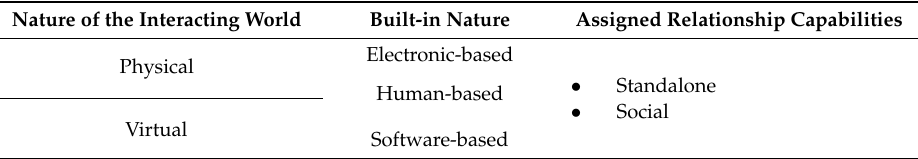
Table 2. Taxonomy of sensors and actuators in